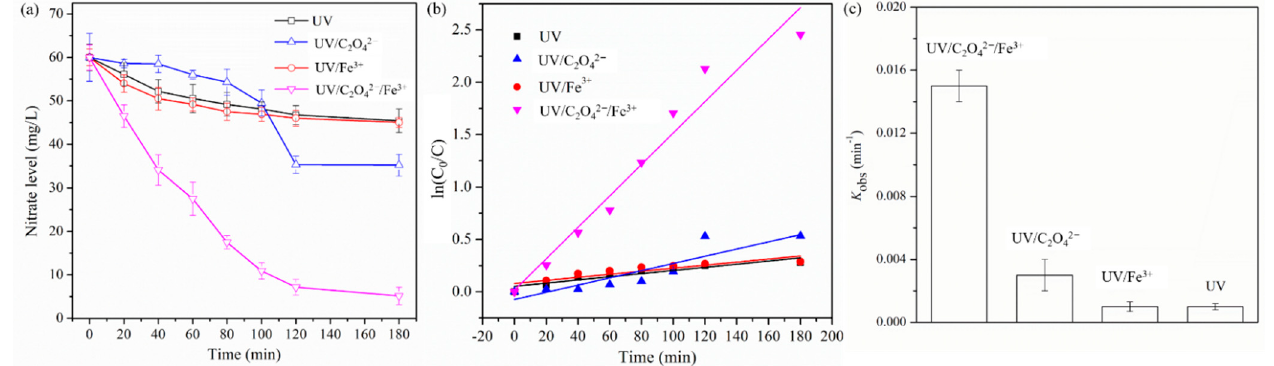
Figure 2. ( a ) Reduction kinetics of NO 3 ‒ in the UV/C 2 O 42 ‒ /Fe 3+ systems, ( b ) the ln(C 0 /C) versus reaction time, and ( c ) their pseudo-first-order rate constants ( k ). Experimental conditions: [NO 3 ‒ ] 0 = 60 mg/L, [C 2 O 42 ‒ ] 0 = 3 mM, [Fe 3+ ] 0 = 0.05 mM, I 0 = 10.2 mW/cm 2 (wavelength = 365 nm), [DO] 0 = 0.5 ± 0.1 mg/L, pH ini. = 7.0 ± 0.2, and T = 25 ± 0.5 °C. Error bars represent the standard deviation from three experiments.